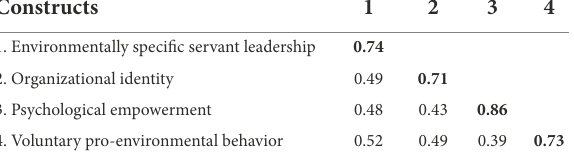
TABLE 2B Fornell–Larcker criterion.